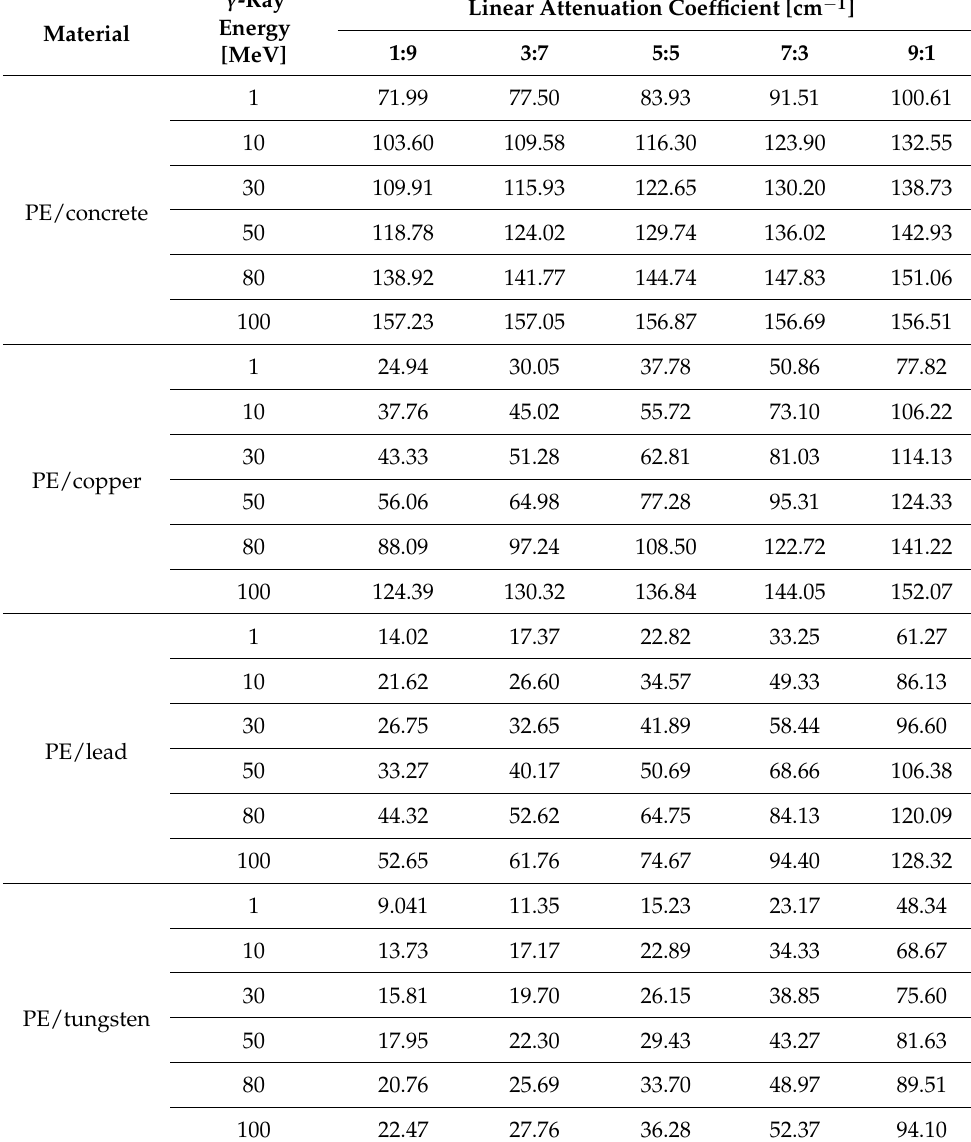
Table 4. Calculated thickness of laminated composites with 99.99% shielding